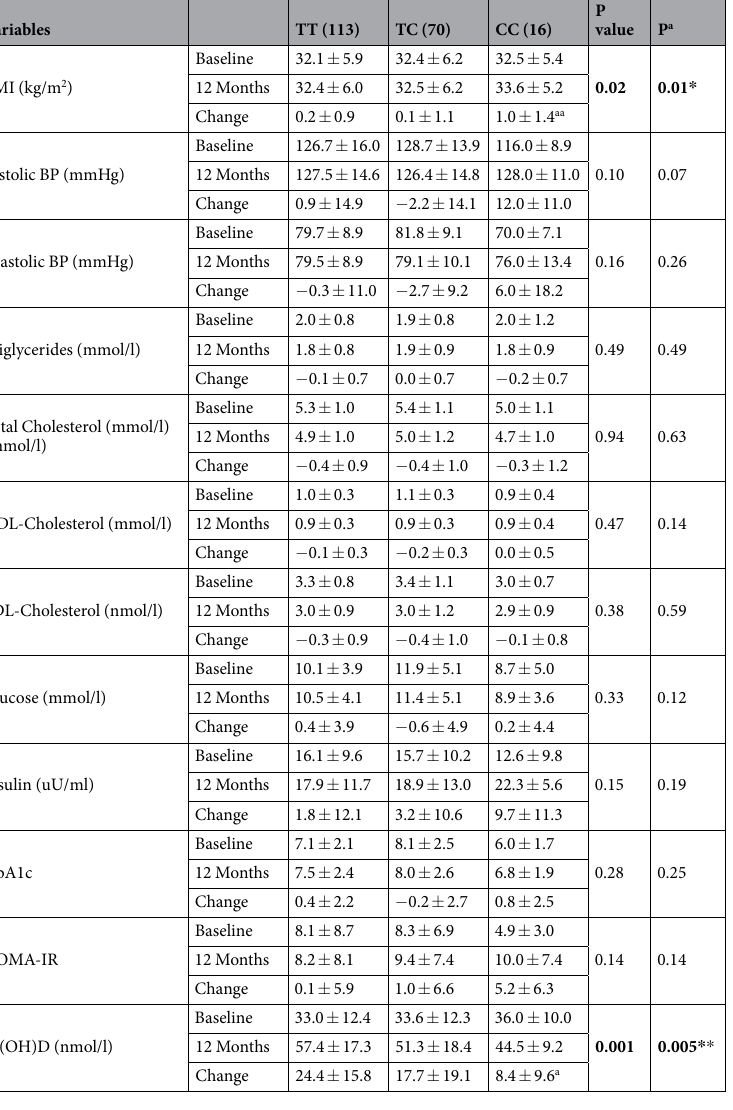
Table 3. Comparisons of the variables among the Fok-I genotypic before and after 12 months of vitamin D supplementation. Note: Change = Follow up − Baseline; p values presented are for the changes in different variables after vitamin D supplementation according to Fok-I genotypes; P a indicates p values after adjusting age, gender, BMI and baseline 25(OH)D levels; Superscript “a” indicates significantly different from TT group after post hoc analysis; “ * ” indicates p < 0.05 after Bonferroni